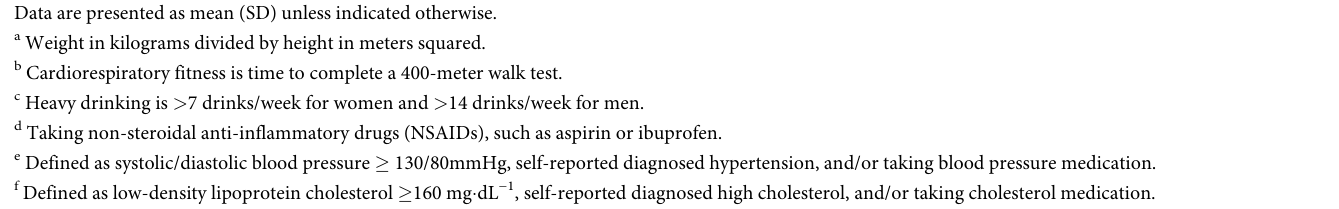
(Model 1). The association remained significant in the overweight group after further adjust- ing for lifestyle factors and medical conditions (Model 2), as well as CRF (Model 3). In the obese group, however, the association was no longer significant after adjustment for covariates or further adjustment for CRF. In the sensitivity analysis, ORs for diverticulitis were similar to using tertiles of CRF. Compared to quartile 1 (least fit), the ORs (95% CIs) for CRF quartiles in the fully adjusted model were 0.42 (0.15–1.28), 0.80 (0.29–2.21), and 0.39 (0.11–1.45), respec- tively, in quartiles 2, 3, and 4 (most fit). Fig 1 shows the results from the joint analysis of CRF and BMI on diverticulitis. Compared to the “unfit and overweight/obese” group, the “fit and overweight/obese,” “unfit and normal weight,” and “fit and normal weight” groups had ORs (95% CIs) of 0.57 (0.24–1.38), 0.65 (0.16–2.59), and 0.16 (0.04–0.61), respectively. Participants were divided into four groups based on combined categories of cardiorespira- tory fitness (unfit or fit) and body mass index (normal-weight, overweight/obese), respectively. "Unfit" was the lower third of cardiorespiratory fitness and "fit" was the upper two thirds of cardiorespiratory fitness. Normal weight was body mass index < 25.0 kg/m 2 , overweight/